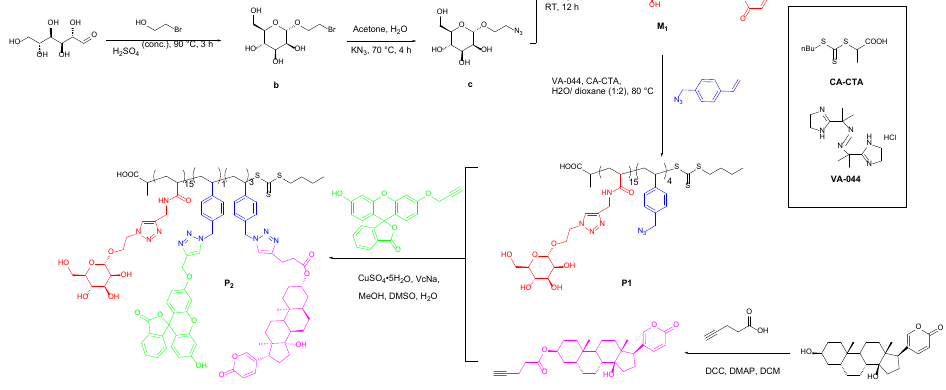
Scheme 1. The flowchart of the synthesis process.